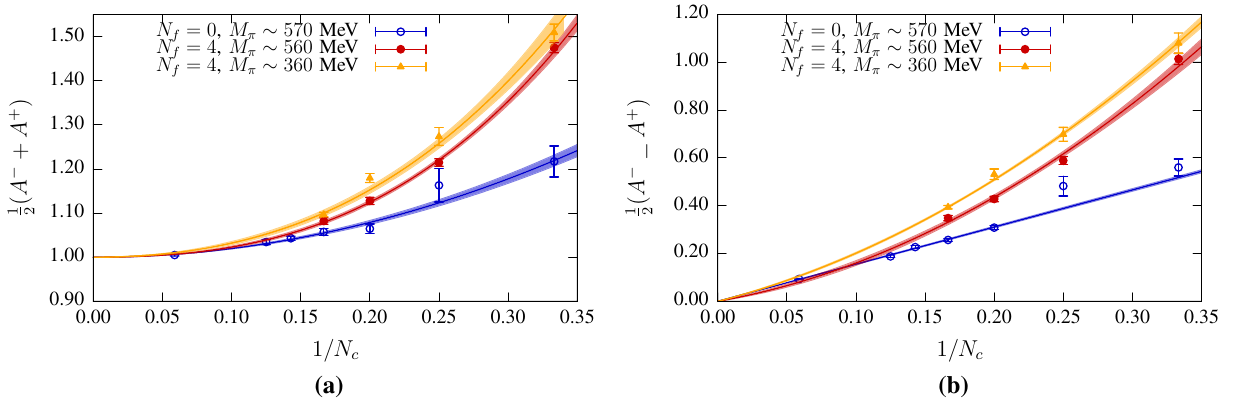
(red), and (iii) dynamical results at a lighter pion mass (orange). The fit results are shown in Table 5. Error bars include only statistical errors